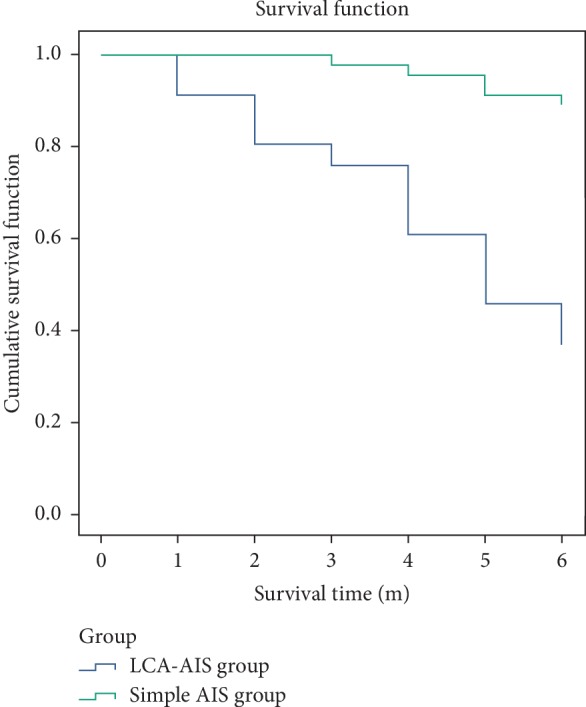
Patient survival function in the LCA-AIS group and simple AIS group.